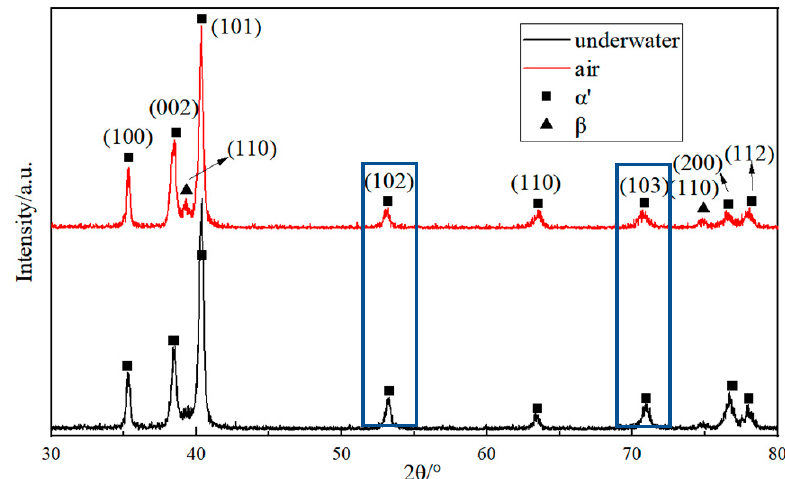
Figure 10. the XRD analysis pattern of TC4 alloy welds in air and underwater. Figure 10. The XRD analysis pattern of TC4 alloy welds in air and